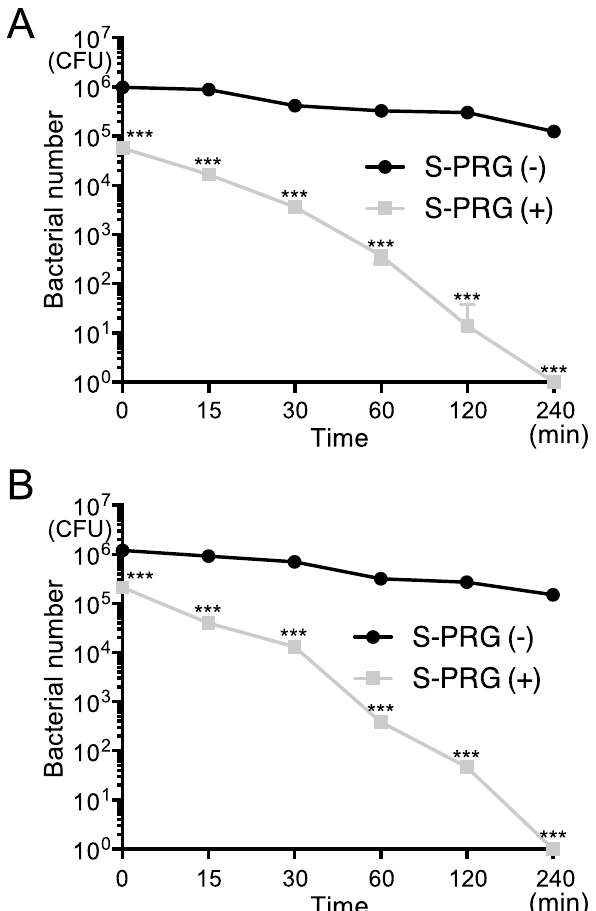
Figure 6. Chronological changes in the number of S. mutans on monofilaments with S-PRG filler. ( A ) Number of S. mutans adhering to nylon monofilaments with and without S-PRG filler at each time point. Significant differences were determined using a chi-square test. *** P < 0.001 compared with nylon monofilaments without S-PRG filler at each time point. ( B ) Number of S. mutans adhering to polyester monofilaments with and without S-PRG filler at each time point. Significant differences were determined using a chi-square test. *** P < 0.001 compared with polyester monofilaments without S-PRG filler at each time